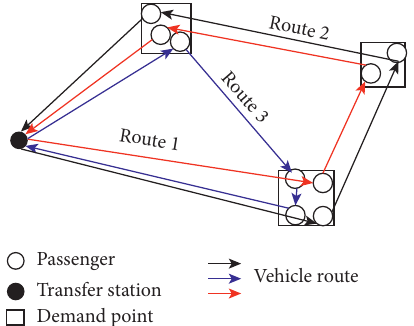
Figure 3: Vehicle route represented by